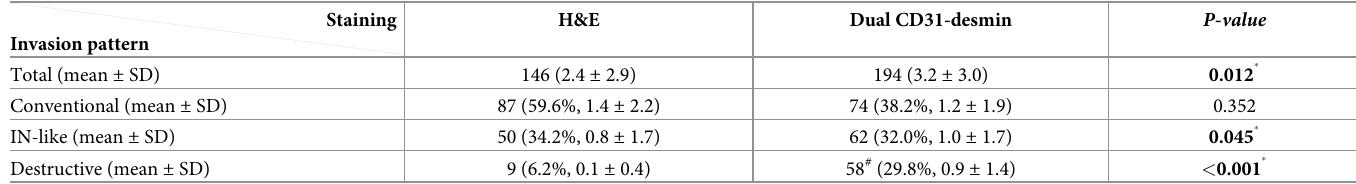
Table 4. Focus-by-focus comparisons of vascular invasion patterns observed by H&E and dual CD31–desmin immunolabeling of the validation